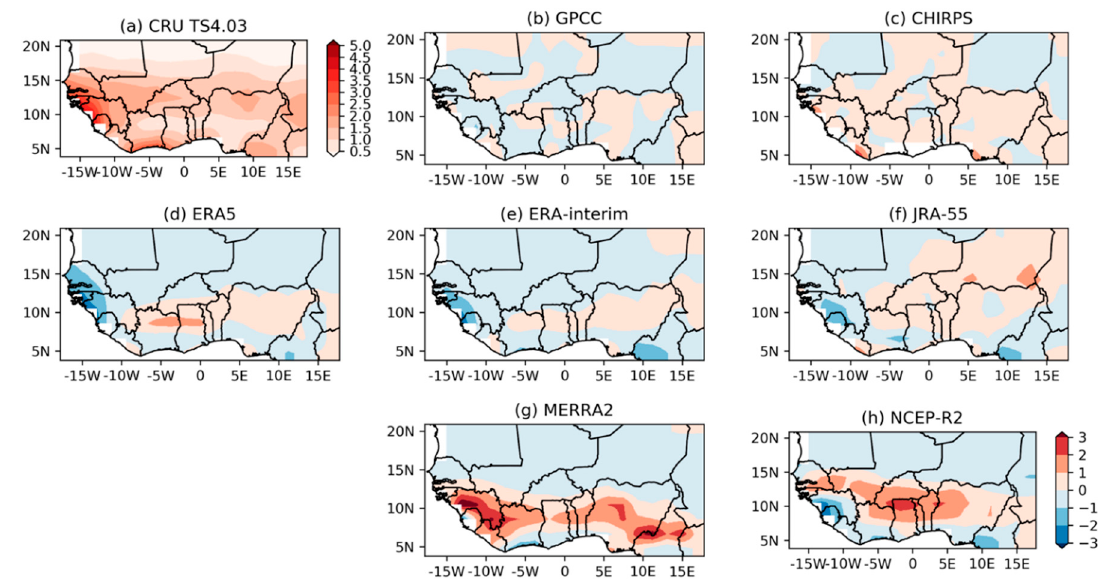
Figure 4. Interannual standard deviation of mean JJAS precipitation (mm day -1 ) over West Africa for three observations ( a – c ); CRU, GPCC, and CHIRPS, and five reanalysis datasets ( d – h ). Plot shows mean differences from CRU for the 1981–2016 period.